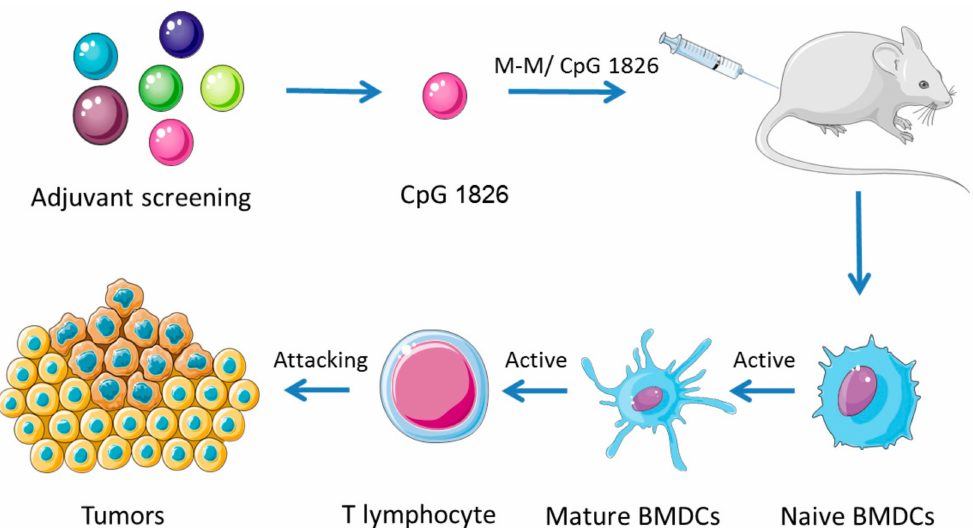
Figure 6. The schematic outline of CpG 1826 as a promising M-M vaccine adjuvant induced DC maturation and enhanced antitumor immunity. CpG 1826 displayed the more prominent effect compared with a series adjuvants. Through in vitro and in vivo study, we found the combination of M-M and CpG 1826 strongly enhanced the maturation of DC and, thus, activated T lymphocytes. Collaboratively, better prophylactic and therapeutic tumor immunotherapy effect were